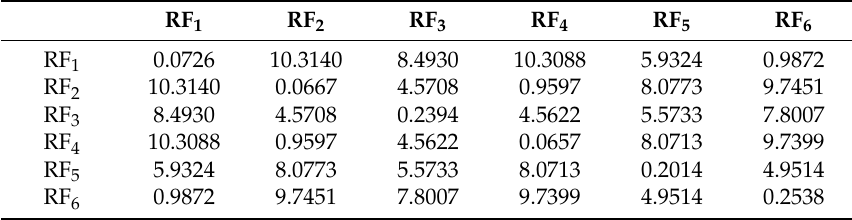
Table 7. The average Euler distance based on the RS-DFV consisting of ( f 32 , f 6 , f 95 , f 19 , f 2 ).